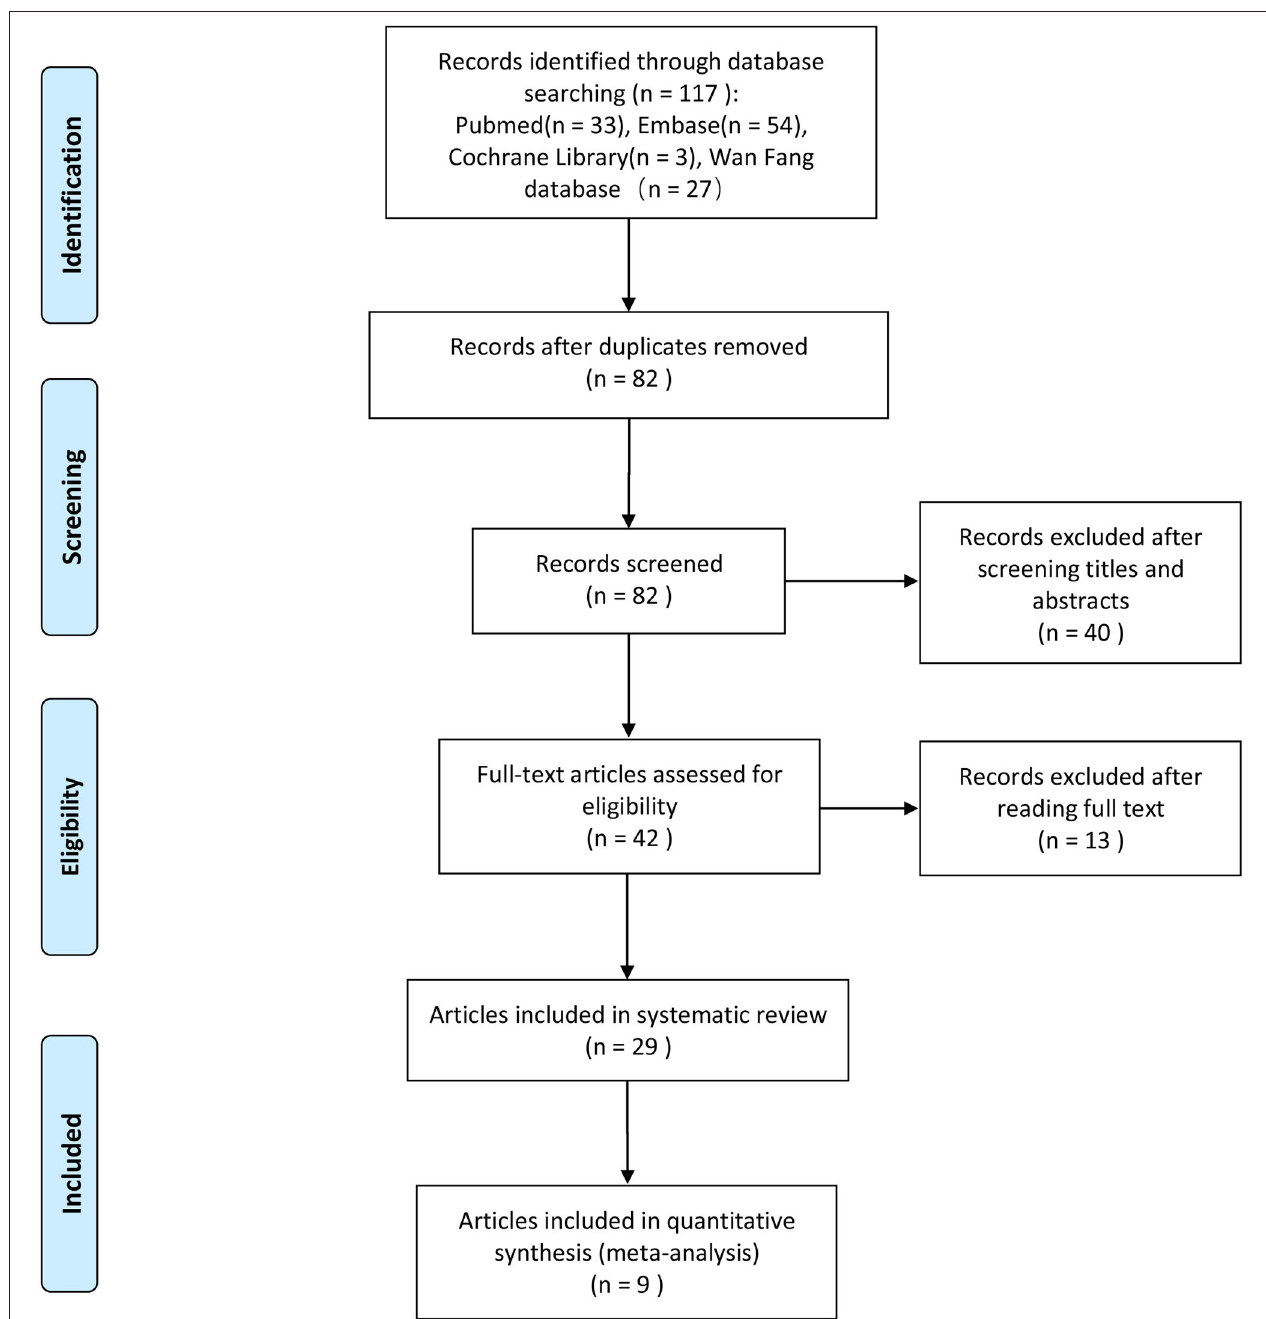
FIGURE 1 | Flow diagram of article